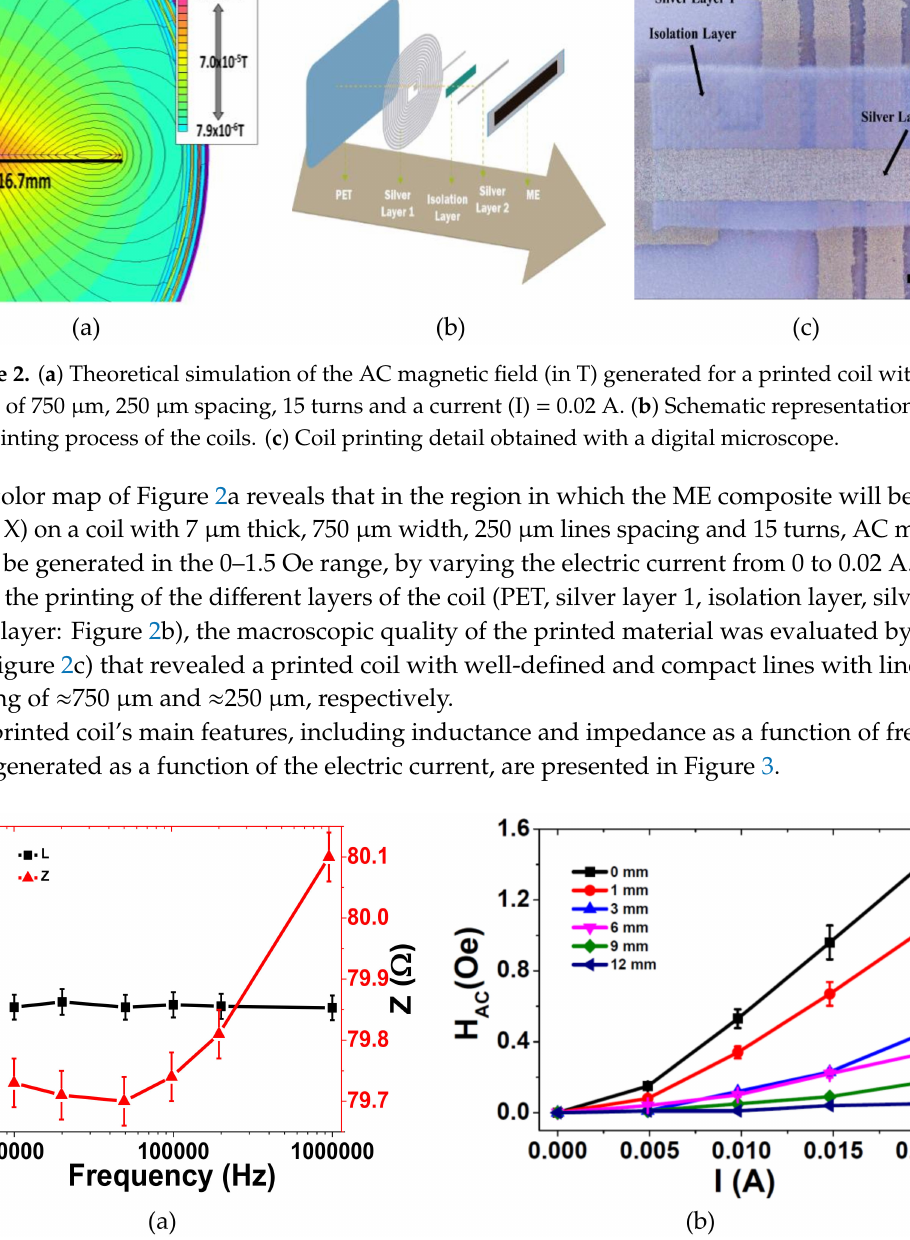
Figure 3. ( a ) Inductance and impedance of the printed coil as a function of frequency. ( b ) H AC value as a function of the distance to the coil and